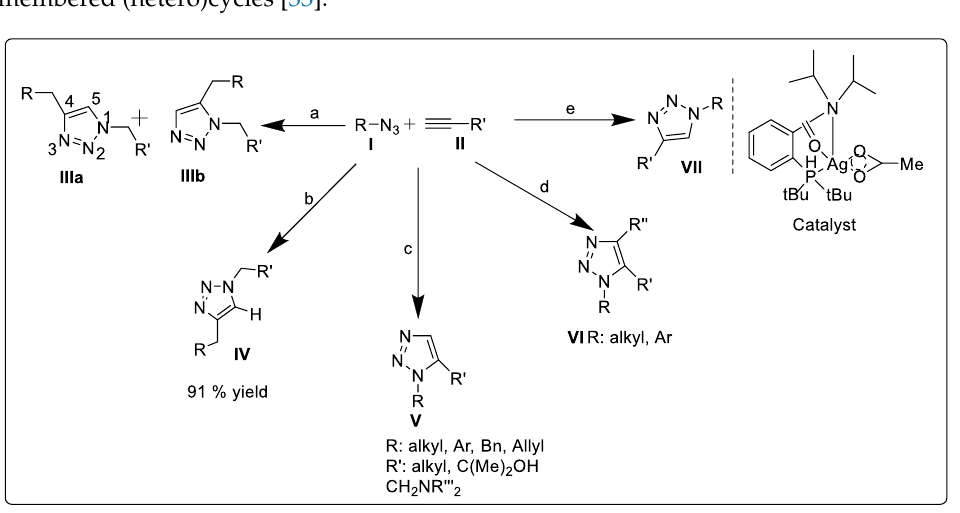
Figure 3. Synthesis of 1,2,3-triazoles: a) 18 h, 98 °C; b) CuSO 4 .5H 2 O (1 mol%), sodium ascorbate (5 mol %), H 2 O/t-BuOH (2:1),25°C, 8 h; c) 2 mol-%, Cp*RuCl(PPh 3 ) 2 , dioxan, 60°C, 12hr; d) 2 mol-%, bate (5 mol %), H 2 O/t-BuOH (2:1),25 ◦ C, 8 h; (c) 2 mol-%, Cp*RuCl(PPh 3 ) 2 , dioxan, 60 ◦ C, 12 h; Cp*RuCl(COD), toluene, RT, 30 min; e) catalyst (2-2.5 mol %), caprylic acid (20 mol%), toluene, 24 (d) 2 mol-%, Cp*RuCl(COD), toluene, RT, 30 min; (e) catalyst (2–2.5 mol %), caprylic acid (20 mol%), hr, 90°C. toluene, 24 h, 90 ◦